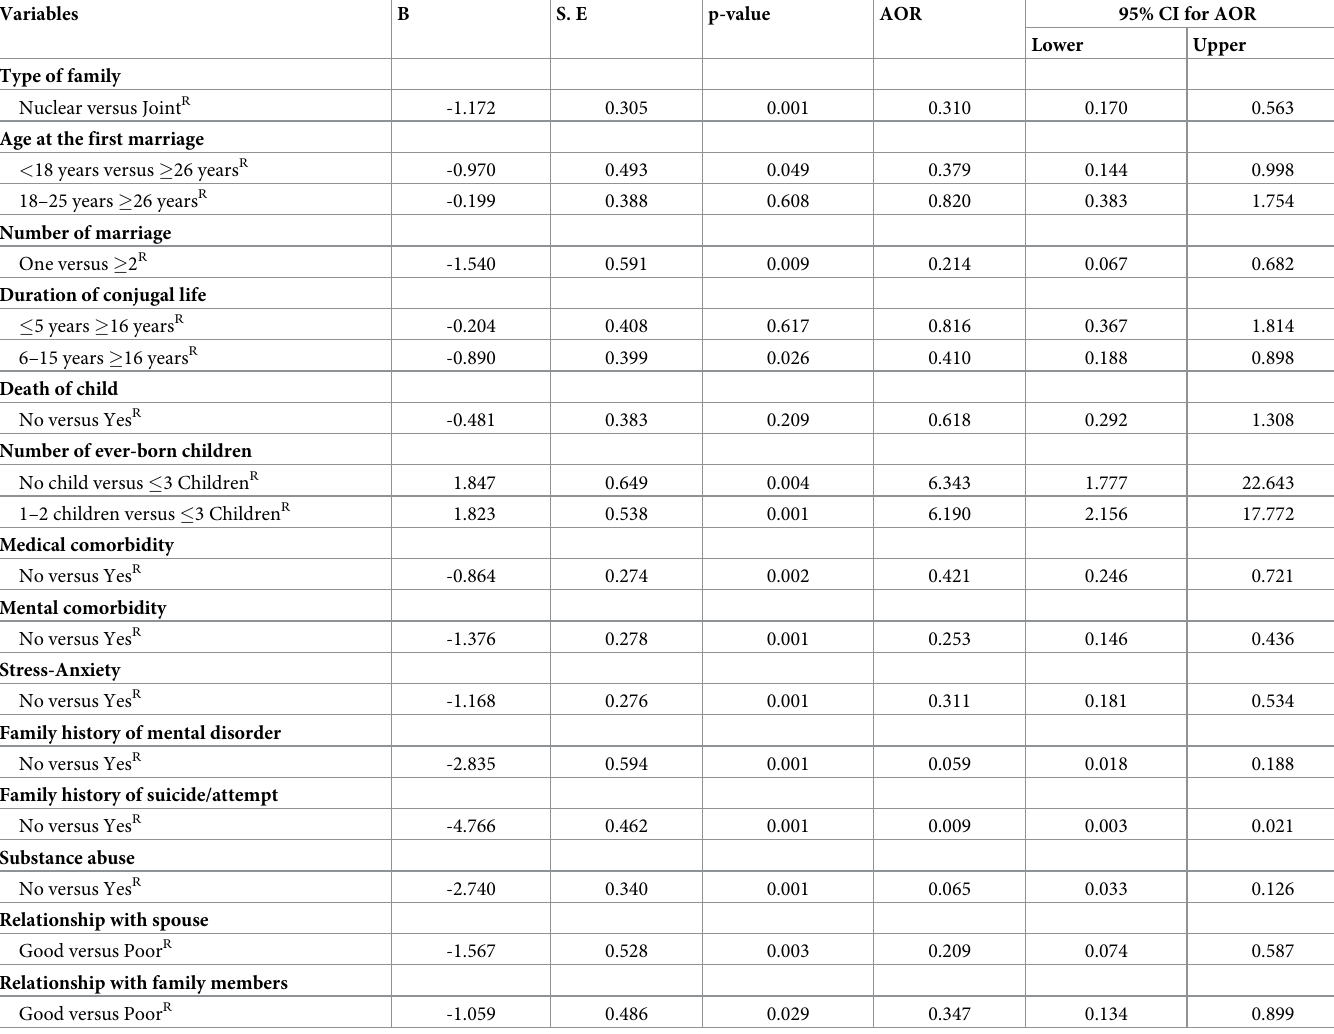
Table 3. Effect of the associated factors on suicidality among married adults (n = 708) in Rajshahi City, Bangladesh.